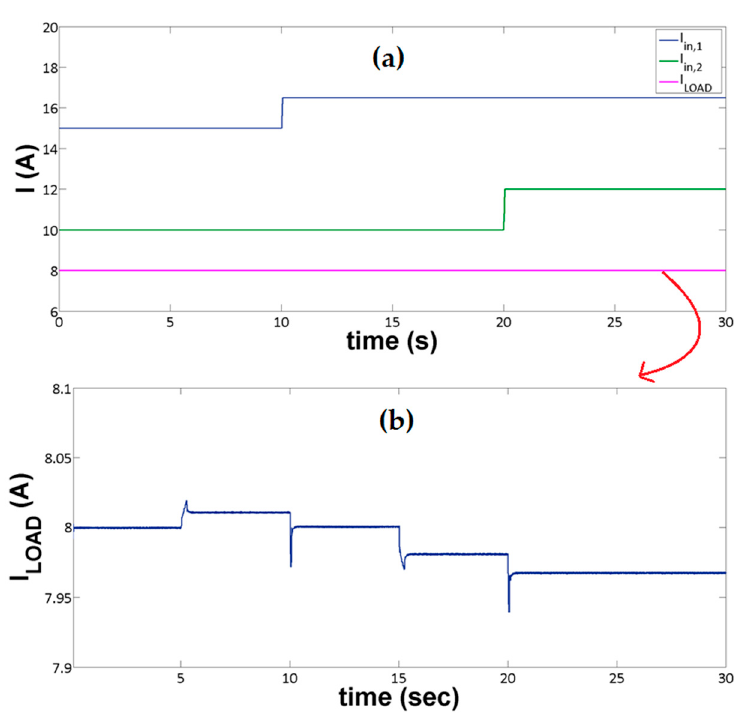
Figure 5. ( a ) The net input supply at each distributed energy resource (DER) bus and the current at the constant power load bus. ( b ) Details of the current changes of the constant power load at the load bus (zoomed).